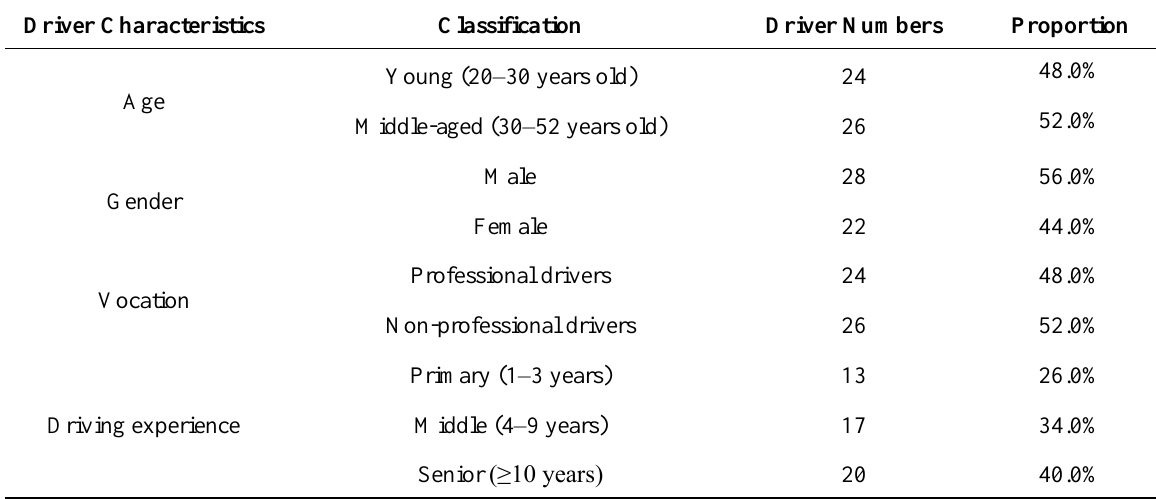
Table 1. Descriptive statistics of